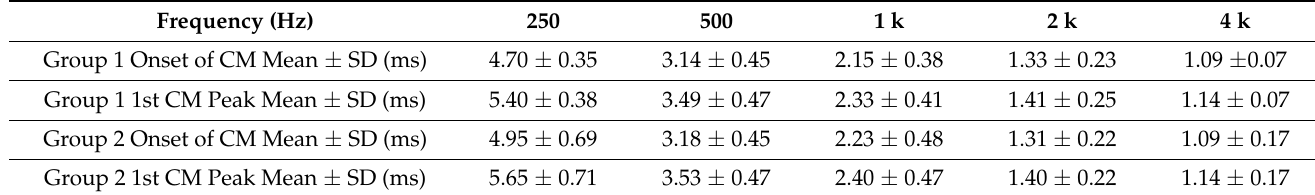
Table 2. Comparisons of the latencies for two different groups. Group 1 contained subjects with hearing better than or equal to the PTA (125–1000 Hz) of 75 dBHL ( n = 8; n = 3 at 250 Hz; n = 8 at 500 Hz; n = 8 at 1–4 kHz). Group 2 included subjects with hearing worse than the PTA (125–1000 Hz) of 75 dBHL ( n = 8; n = 3 at 250 Hz; n = 7 at 500 Hz; n = 8 at 1–4 kHz). For the minimum effect of the interest equal to SD, power of 0.8 and higher was reached for frequencies 0.5, 1, 2, and 4 kHz. For 250 Hz, minimum power of 0.5 was